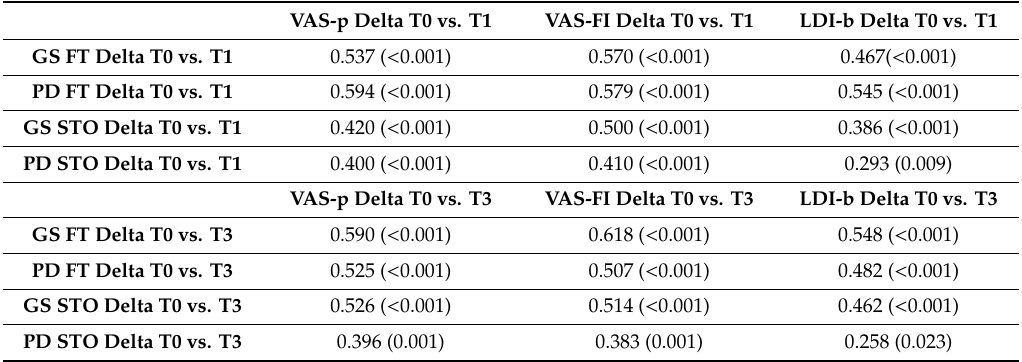
Table 4. Correlation between sonographic lesions and clinical parameters at 1 month and 3 months vs. baseline values. VAS-p Delta T0 vs.